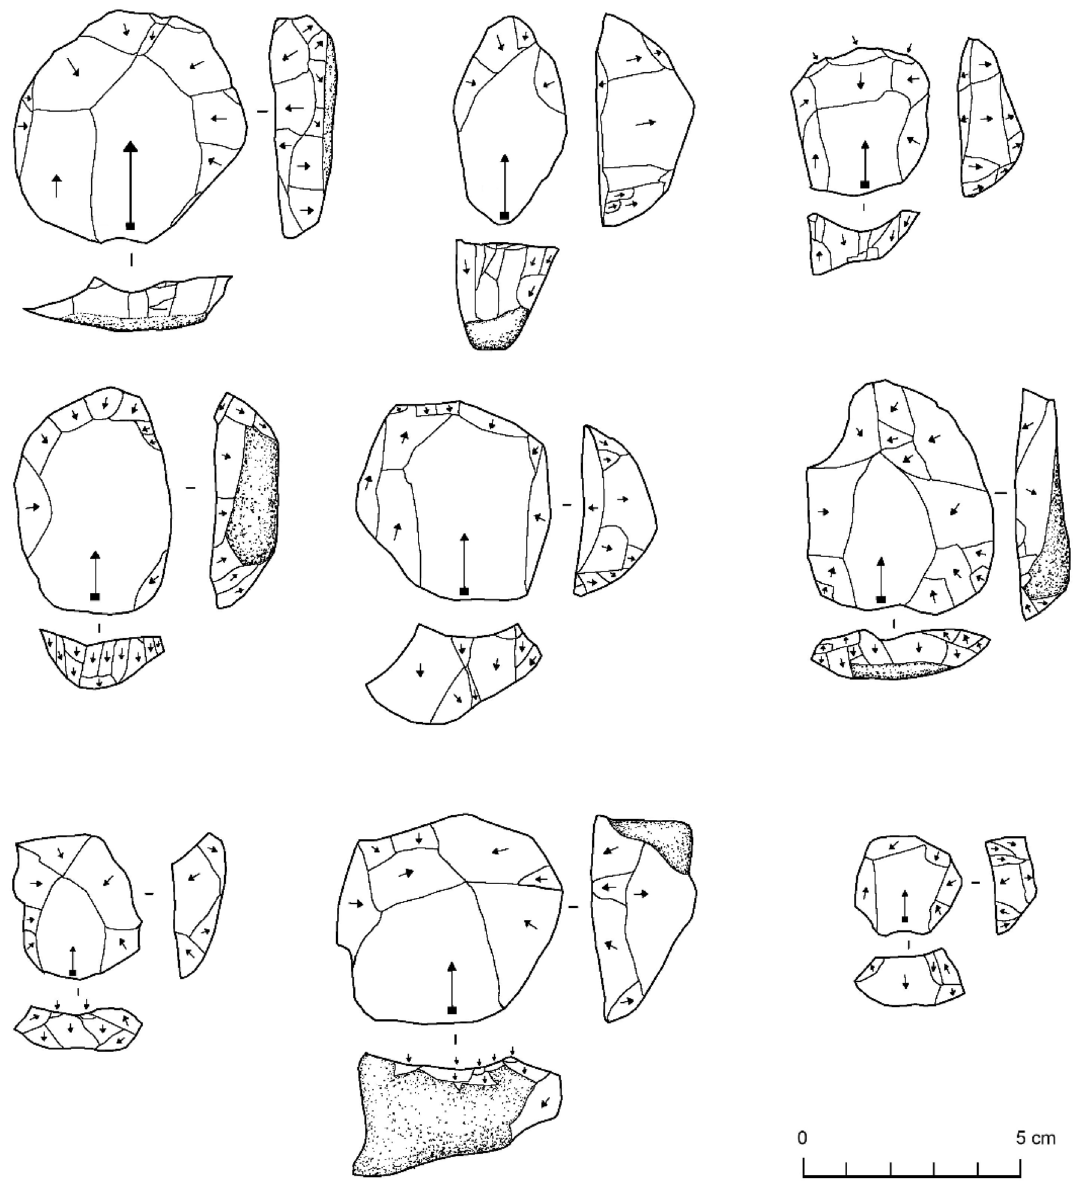
Figure 2. Examples of centripetal Levallois cores from (top) Aduma (A5), (middle) Mundafan (MDF61), and bottom (Al